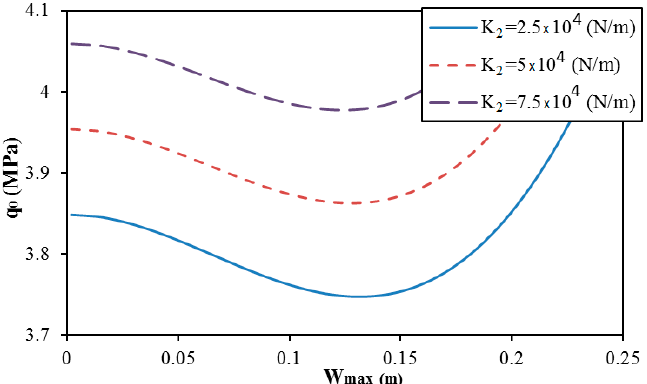
Figure 8. E ff ect of the shear layer modulus of the elastic foundation K 2 on the postbuckling curve of Figure 8. Effect of the shear layer modulus of the elastic foundation 2 K on the postbuckling curve trapezoidal spiral corrugated sandwich FGM cylindrical shells ( e = 0.03 m , f = 0.015 m , δ = π /3, k = 1, of trapezoidal spiral corrugated sandwich FGM cylindrical shells ( N = 1, and K 1 = 10 7 N / m 3